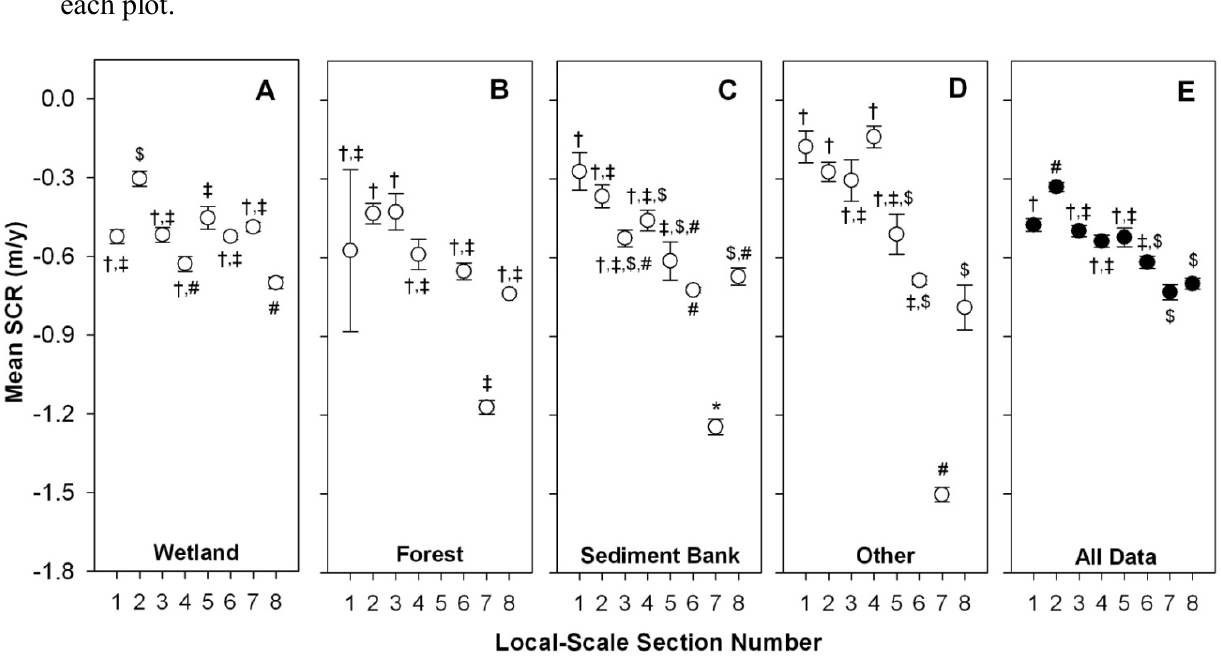
Figure 5. Plot of mean shoreline-change rate values (±1 standard error) for each of the eight sections grouped by land-use land-cover type (LULC) category, displaying the (A) Wetland, (B) Forest, (C) Sediment Bank, (D) other, and (E) the entire dataset. Significantly different values are denoted by different symbols between sections within each plot.